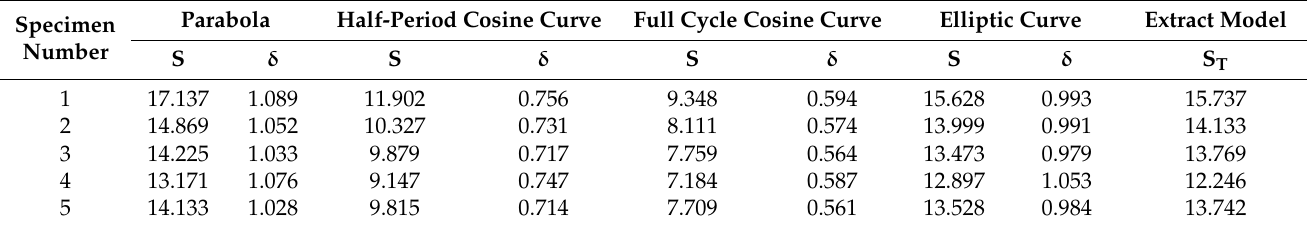
Table 4. Integral value and error value of each